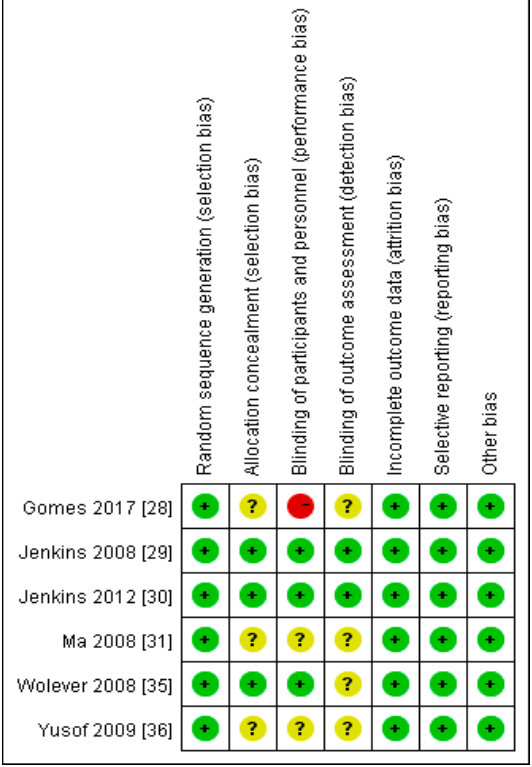
Figure 3. A risk of bias graph.